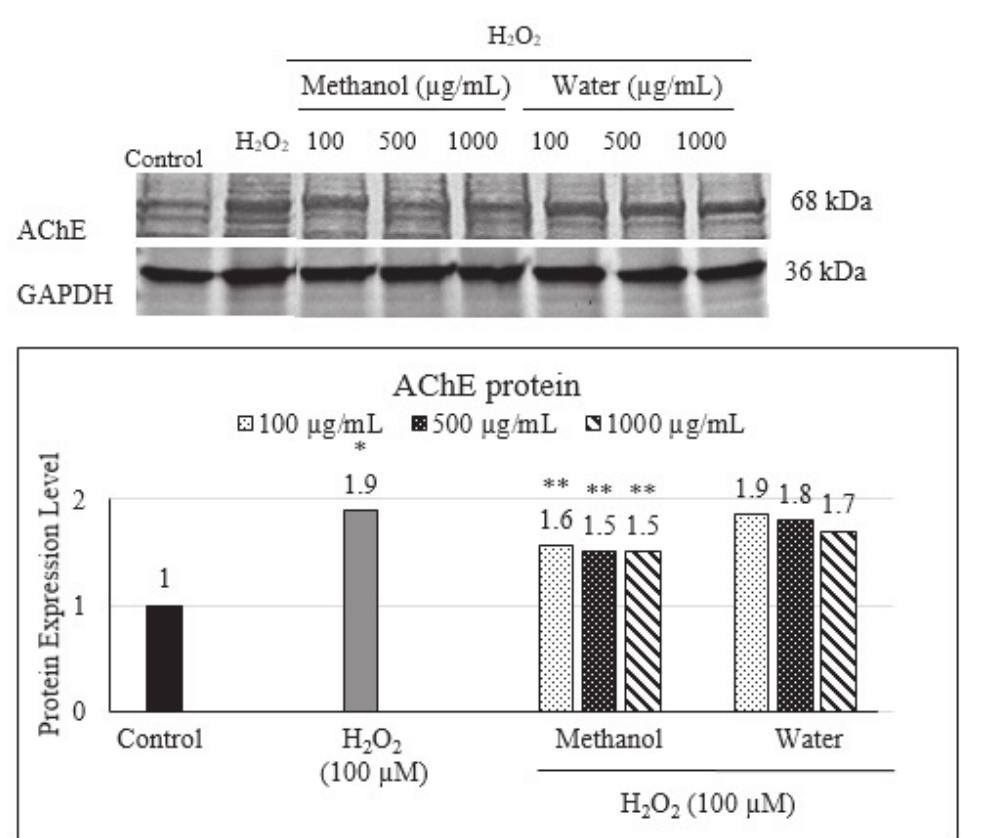
FIGURE 5 - The levels of AChE protein expression in dPC12 cells with different concentrations of G. corniculatum after H * p < 0.05 vs. control group, ** p < 0.05 vs. H